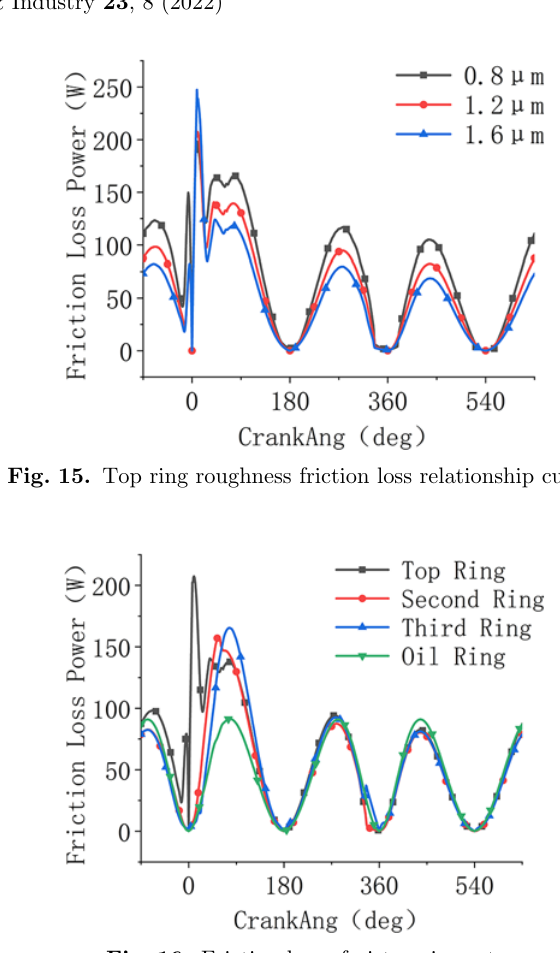
Fig. 16. Friction loss of piston ring set.